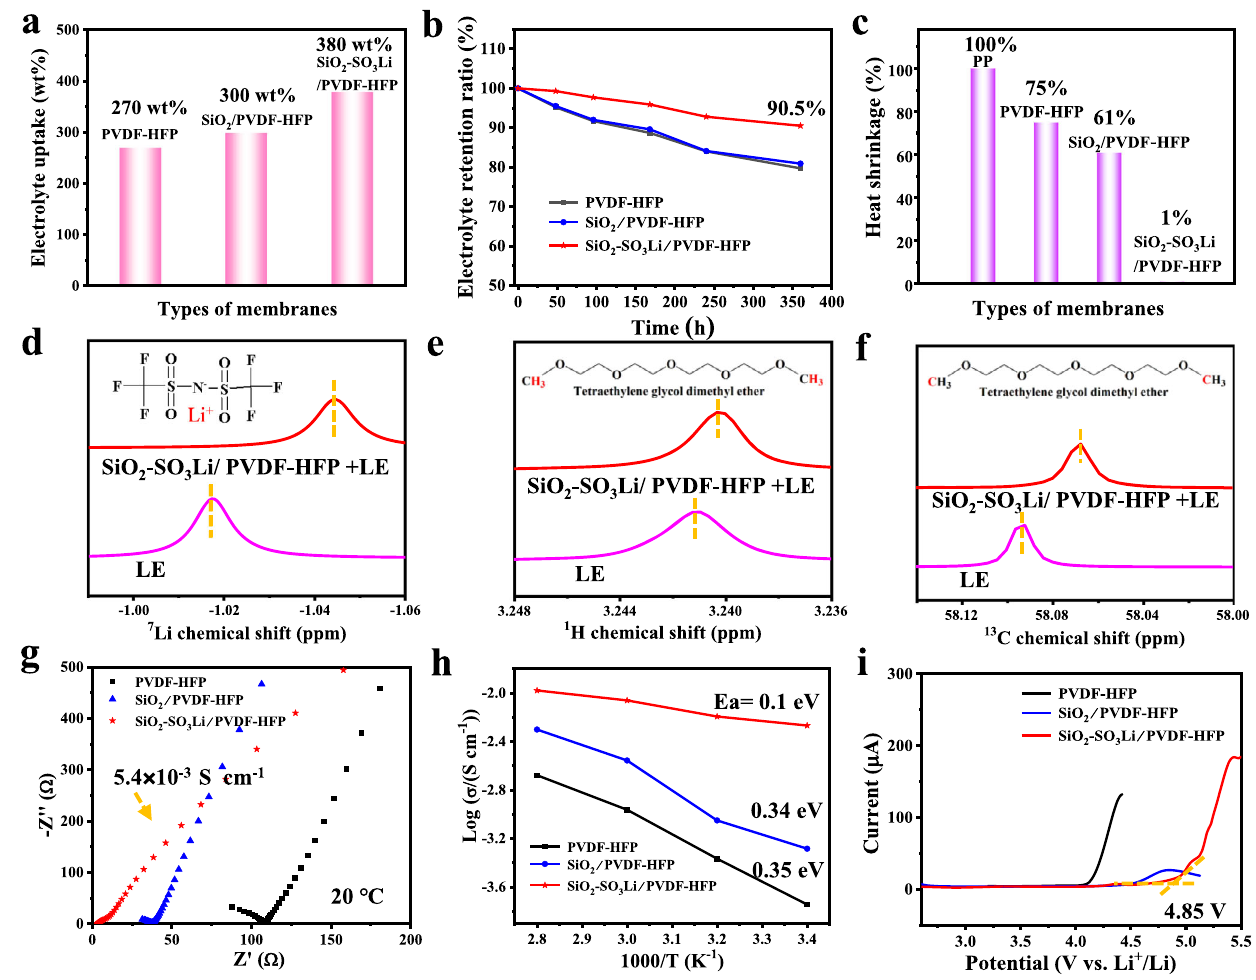
Fig. 3 | Physical, chemical, and electrochemical performances of quasi-solid electrolytes. a Electrolyte uptake; b Electrolyte retention ratio; c Heat shrinkage afterheatedat 180°Cfor 1h; d – f NMRanalysis of the reactionbetween composite